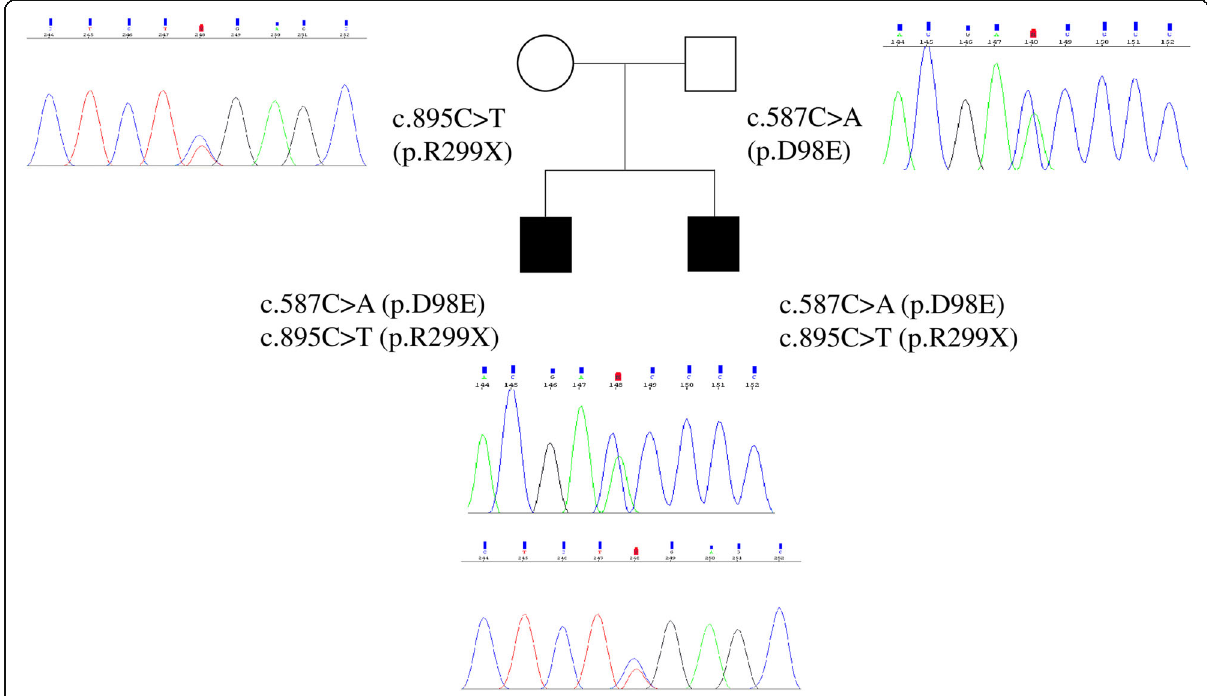
Fig. 1 The family pedigree showing the mutations detected in